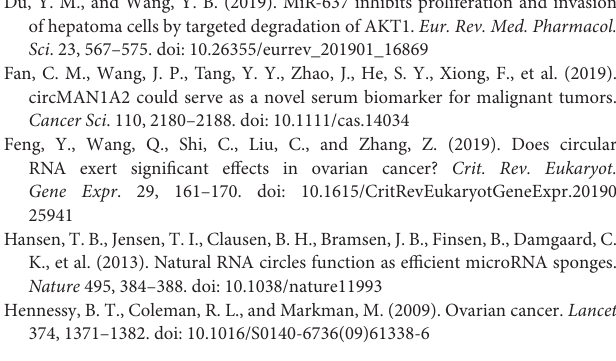
Supplementary Figure 1 | The expression of circ_0013958 in OC cells. Circ_0013958 expression in OC cell line (SKOV3, CAOV3, A2780, and OVCAR-3) and human ovarian surface epithelial cells (HOSE). ∗∗ P < 0.01. Supplementary Figure 2 | The protein level of PLXNB2 in OC tissues. PLXNB2 protein level in OC tissues and adjacent normal tissues. ∗∗ P < 0.01. Supplementary Figure 3 | Correlation between PLXNB2 and circ_0013958 levels in OC tissues. Pearson’s correlation analysis for the correlation between the expression levels of circ_0013958 and PLXNB2 in OC tissues ( n = 30). Supplementary Figure 4 | PLXNB2 level in xenograft tumor tissues with sh-NC or sh-circ_0013958. Immunohistochemistry (IHC) for PLXNB2 in xenograft tumor tissues with sh-NC or sh-circ_0013958. ∗∗ P <